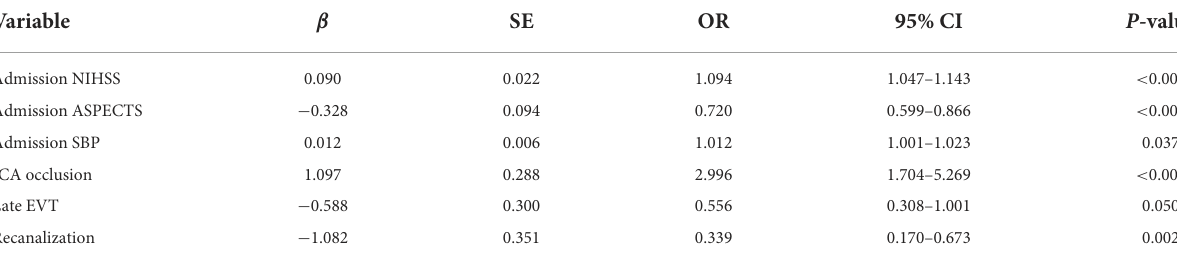
TABLE 3 Multivariable logistic regression of possible predictors of MMI in the denervation cohort.